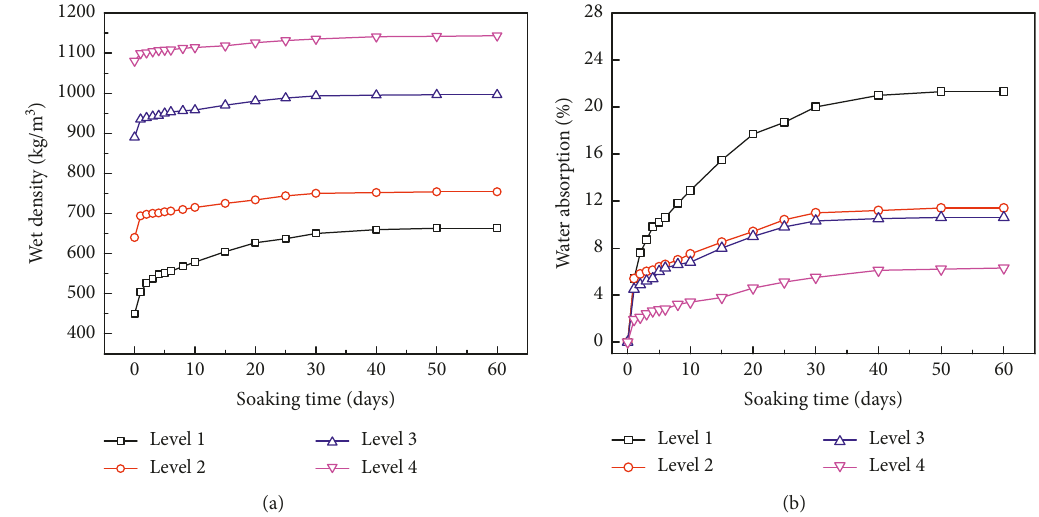
Figure 8: Change in the (a) density and (b) water absorption of FMLSB with soaking time.